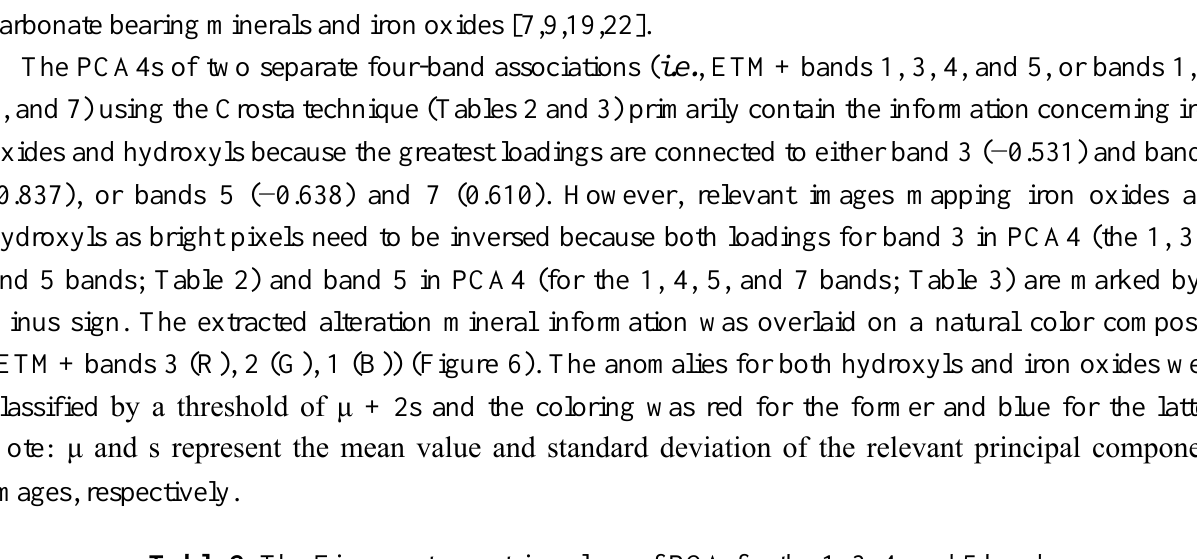
Table 2. The Eigenvector matrix values of PCA for the 1, 3, 4, and 5 bands.